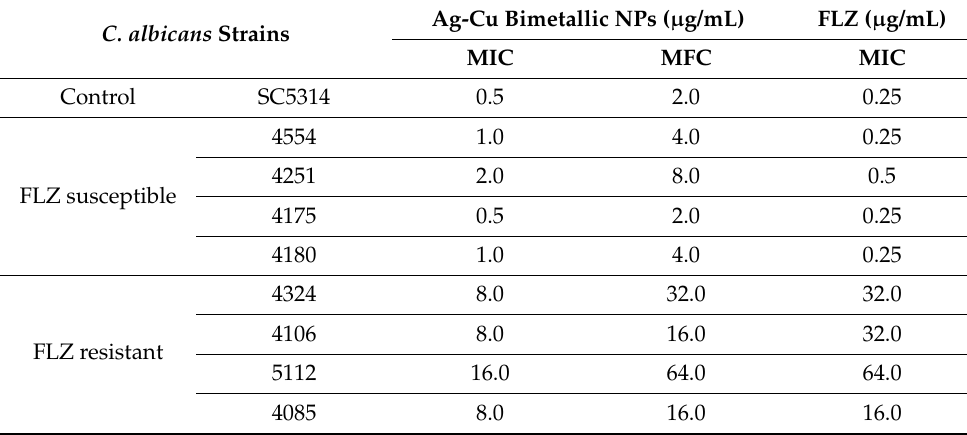
Table 1. MIC and MFC values of Ag-Cu bimetallic NPs against different strains of C. albicans . Ag-Cu Bimetallic NPs ( µ g/mL) C. albicans Strains